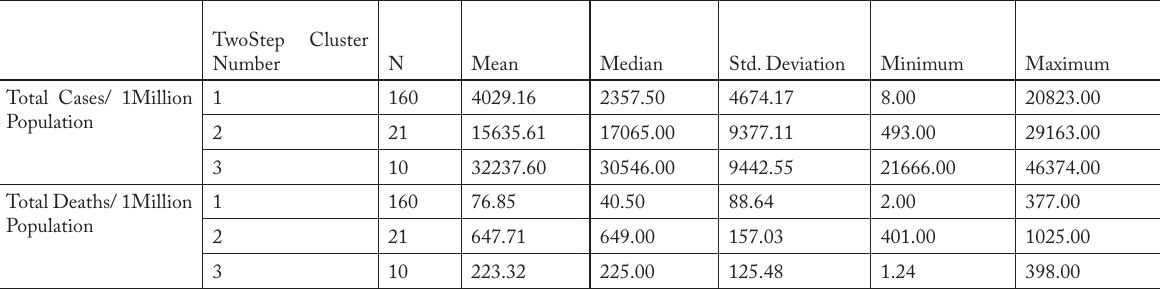
Table 7. Descriptive statistics of clusters according to the two step